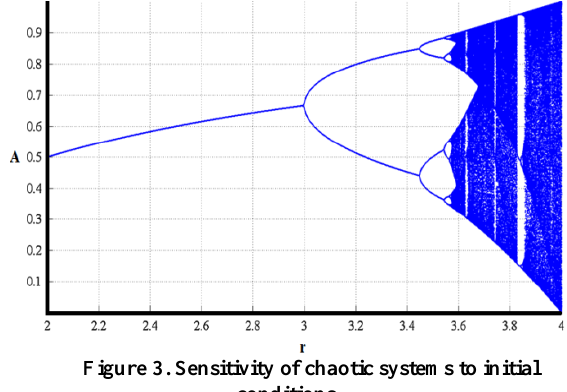
Figure 3. Sensitivity of chaotic systems to initial